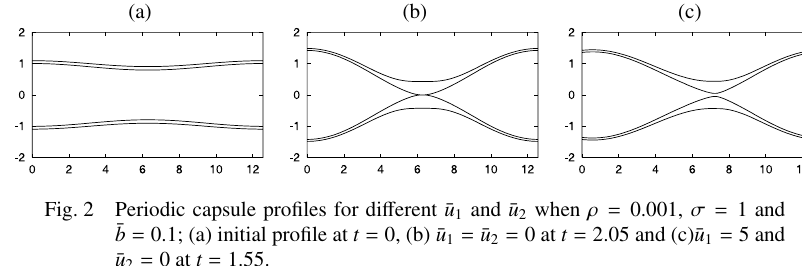
= ¯ u = 0 at t = 2 . 05 and (c)¯ u 1 2